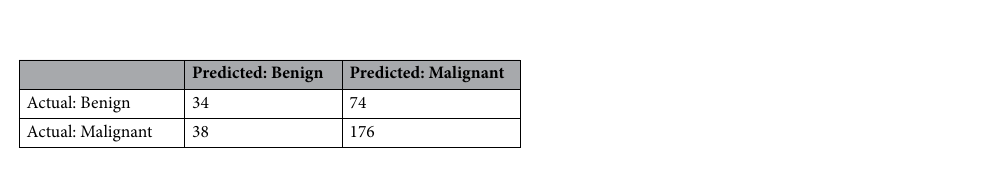
Table 5. Confusion matrix of weakly supervised learning with DenseNet model.